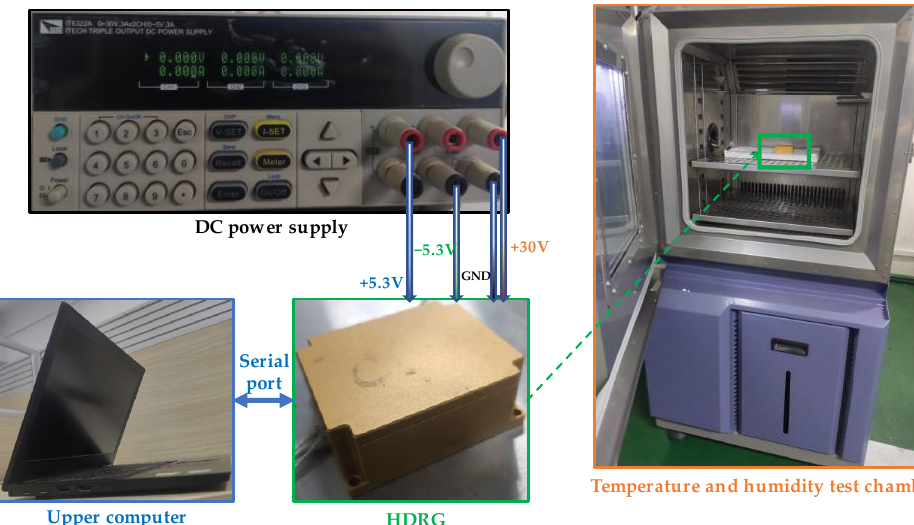
Figure 4. Experimental platform and main equipment.